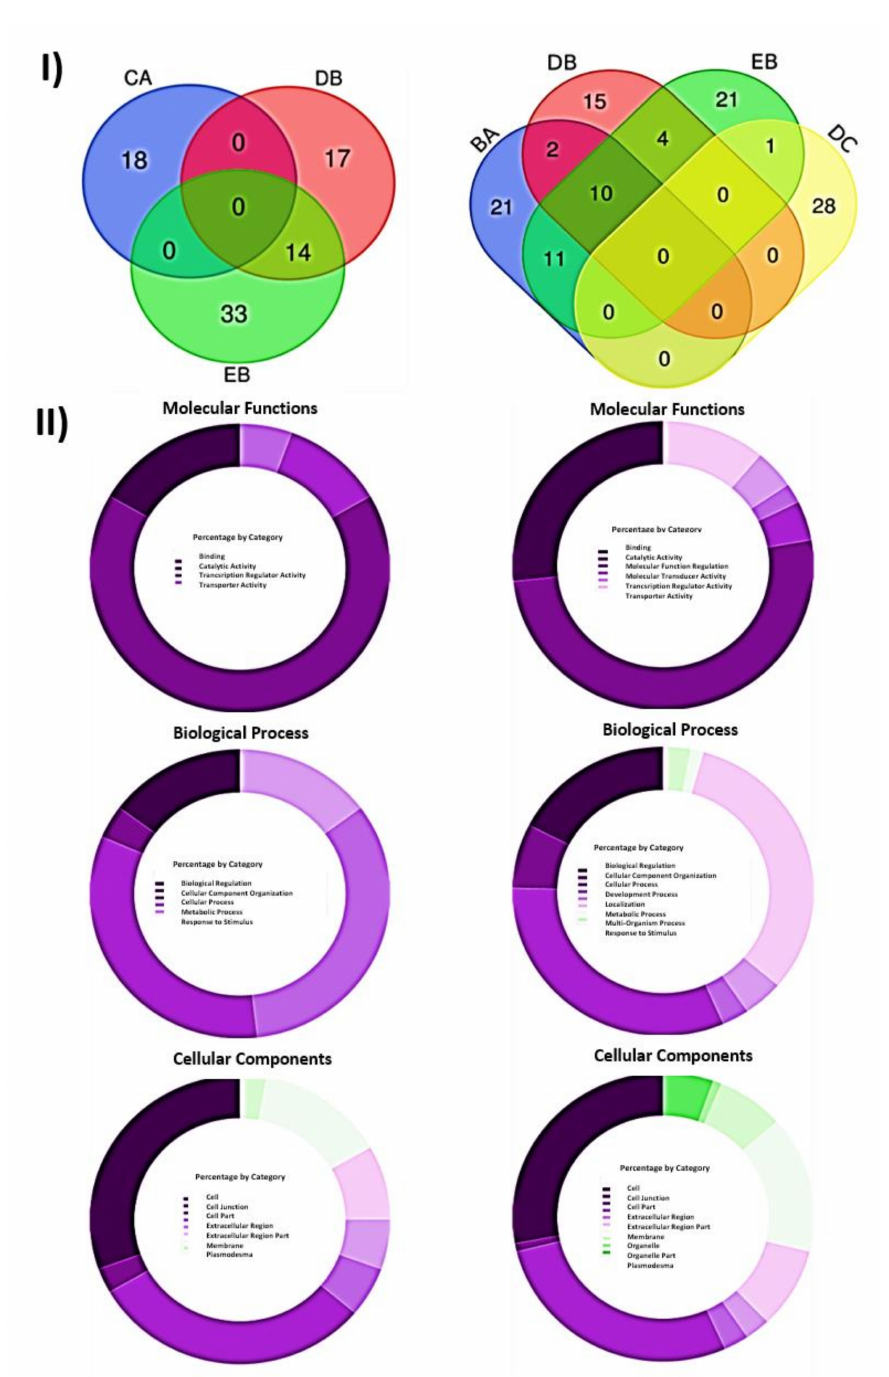
Figure 3. ( I ) Analysis of DEGs associated with grafting (CA vs. DB vs. EB) (left) and inoculation (BA vs. DB vs. EB vs. DC) (right) effects: control healthy “GF305” peach rootstocks; PPV-infected “GF305” rootstocks showing severe sharka symptoms; “GF305” peach rootstocks grafted with healthy “Garrigues”; PPV-infected “GF305” rootstocks showing sharka symptoms grafted with healthy “Garrigues”; healthy “GF305” peach rootstock grafted with healthy “Garrigues” which were later inoculated with PPV at the end of the first cycle of evaluation. “Garrigues” almond samples grafted onto healthy and inoculated “GF305” rootstocks. ( II ) GO term categories obtained by PANTHER for DEGs associated with grafting (left) and inoculation (right) effects. Diagram shows percentage of GO term categories showing the total of each domain for DEGs “Cellular Components”, “Biological Processes” and “Molecular Functions”